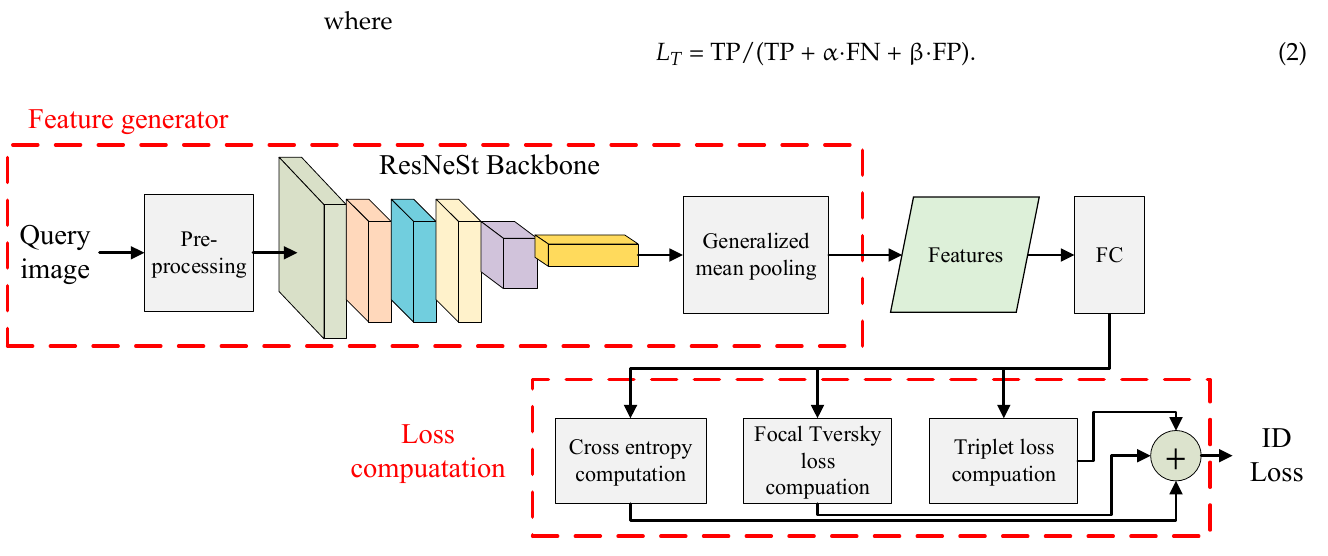
Figure 3. The proposed loss computation.